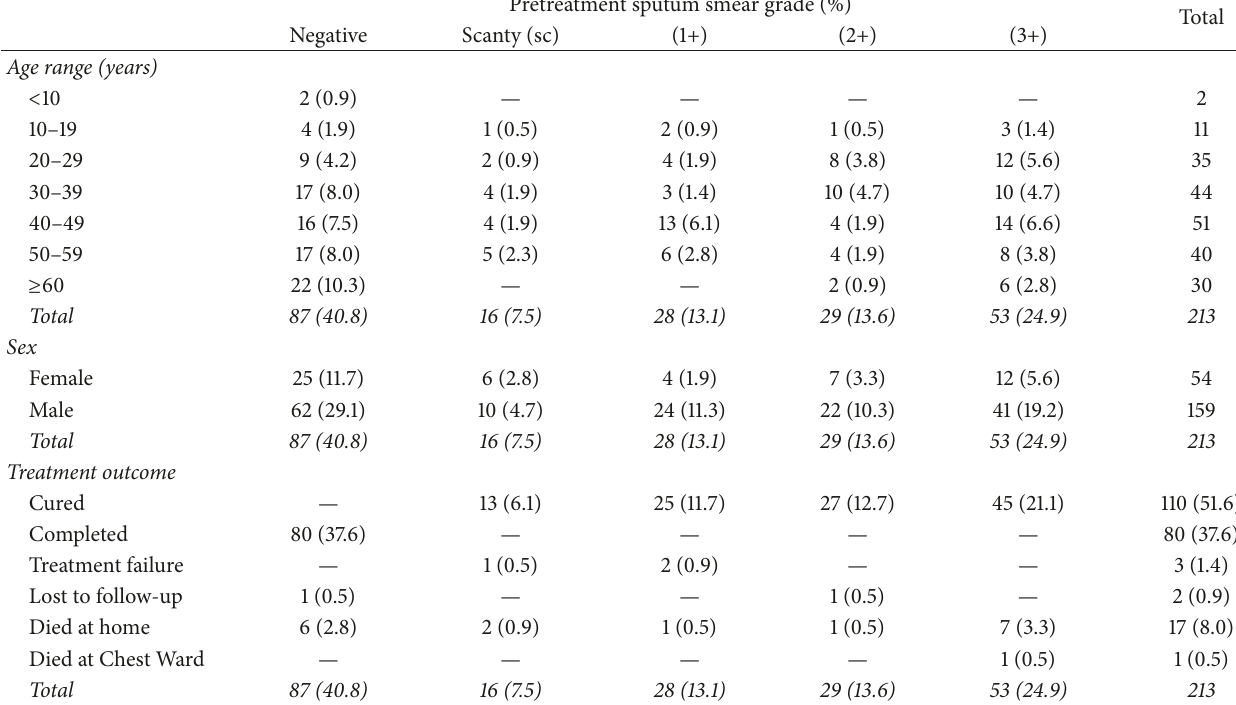
Table 3: Pretreatment sputum smear grade and treatment outcome among clients.